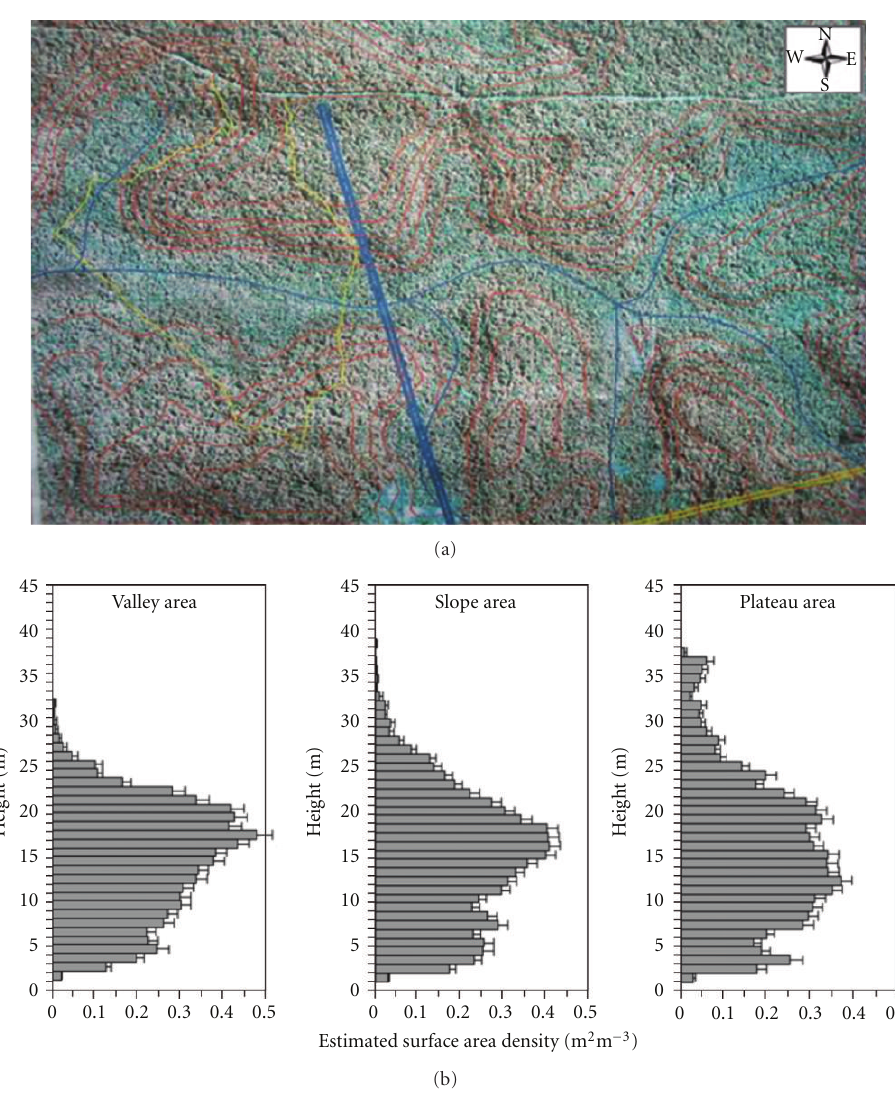
Figure 2: (a) IKONOS’s image of the site at the Ac¸u catchment with level terrain cotes and vegetation cover and (b) vegetation structure measured from LIDAR sensor over yellow transect in (a). From (a) the valley vegetation (blue color) and vegetation transition to plateau areas (red